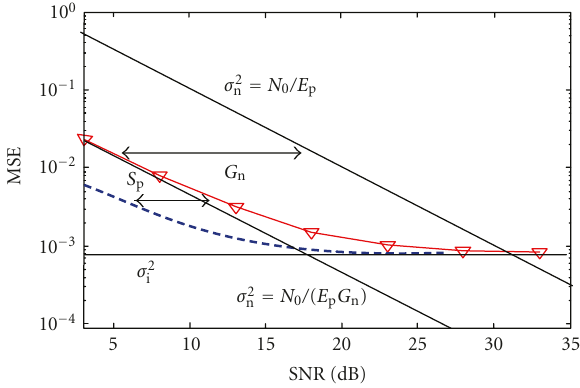
Figure 3: Parametrization of an MSE estimation